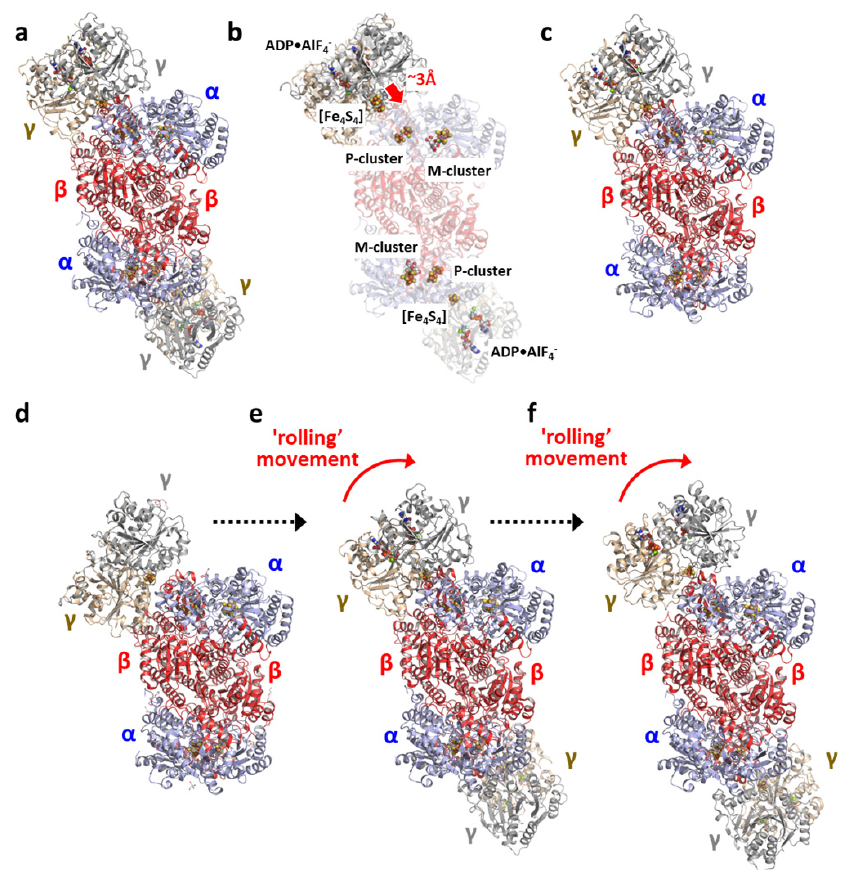
Figure 8. The various Mo-nitrogenase complexes from A. vinelandii . ( a , b ) Crystal structures of the MgADP•AlF 4 ‒ stabilized complex ( a ) alone (PDB entry 1n2c), and ( b ) overlaid with the nucleotide- free NifH (PDB entry 2nip), showing a movement of the [Fe 4 S 4 ] cluster of NifH by ~3 Å (indicated by a red arrow) toward the P-cluster of NifDK upon complex formation. ( c ) Cryo-EM structure of turnover (TO) complex I, showing a molar ratio of 1:1 between NifH and NifDK (PDB entry 7ut8). ( d – f ) Crystal structures of complexes generated ( d ) without nucleotide (PDB entry 2afh); ( e ) with MgADP (PDB entry 2afi); and ( f ) with MgAMPPCP (PDB entry 2afk), showing a plausible “rolling” movement of NifH across the surface of NifDK upon hydrolysis of MgATP. Note that the molar ratio between NifH and NifDK is 2:1 within the complexes generated with non-hydrolyzable MgATP analogs, MgADP•AlF 4 − ( a ) and MgAMPPCP ( f ), and with MgADP ( e ), contrary to the molar ratio of 1:1 between NifH and NifDK within the complexes generated with MgATP under turnover conditions ( c ), and without nucleotide ( d ). The subunits, clusters, MgADP•AlF 4 ‒ , MgADP and MgAMPPCP are presented and colored as those in Figure 1.